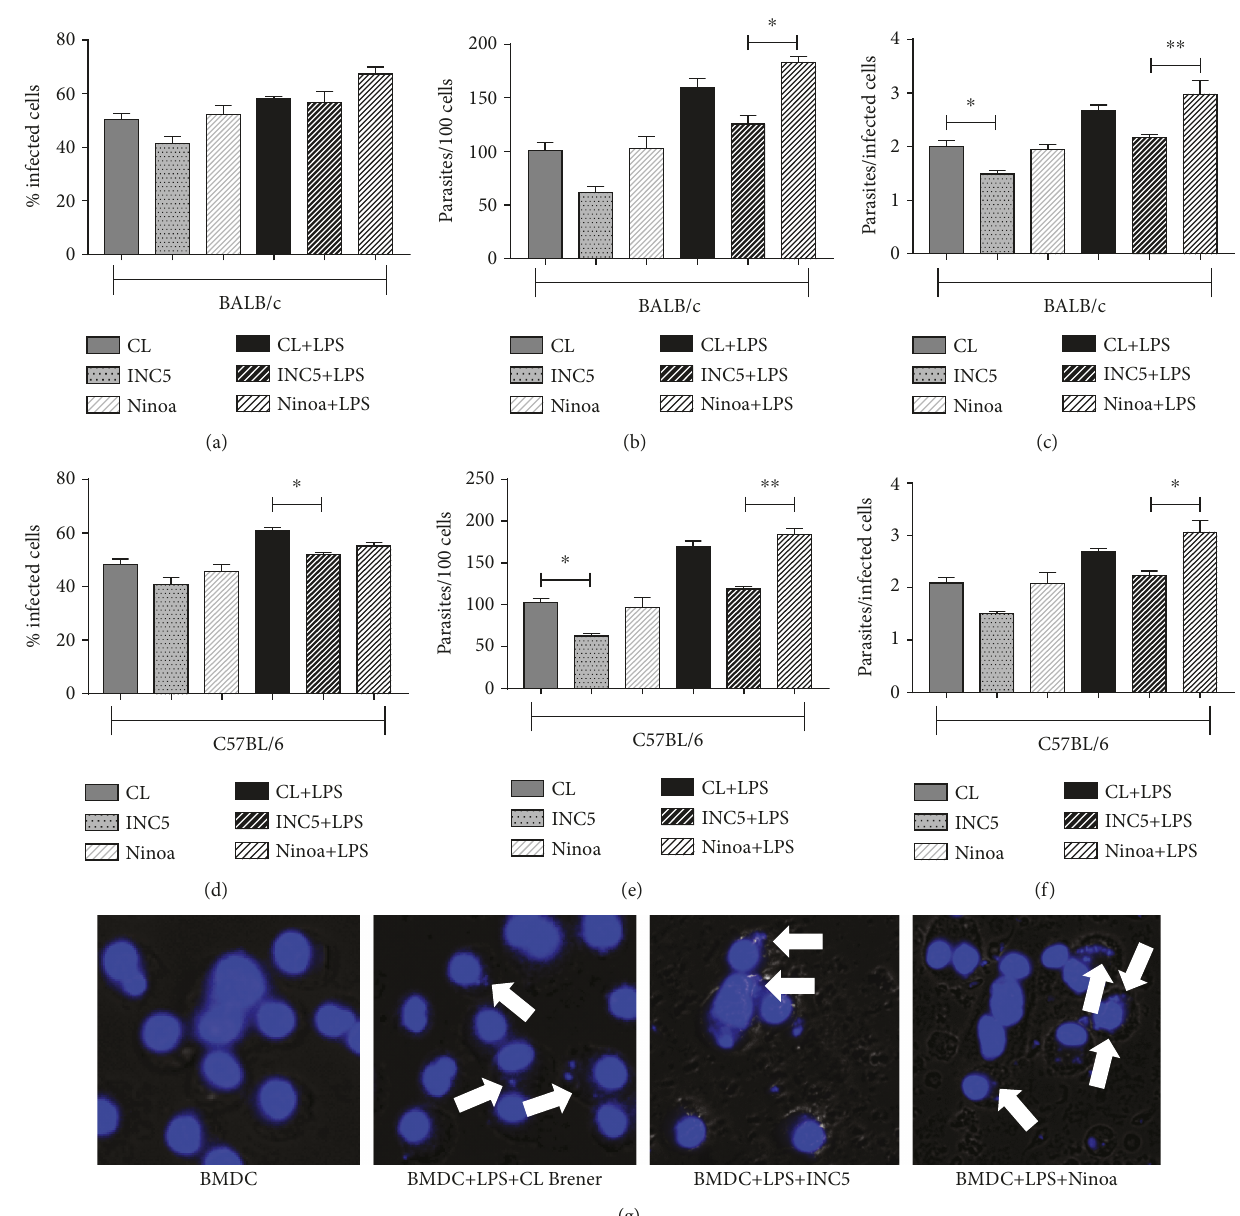
Figure 1: Trypanosoma cruzi infectivity in murine BMDCs from BALB/c and C57BL/6 mice. BMDCs with or without LPS stimulation (5 μ g/mL) were incubated for 18h with di ff erent T. cruzi strains (MOI 2:1) and stained with DAPI. (a) and (d) show the percentage of infected cells; in (b) and (e) the number of parasites per 100 cells and in (c) and (f) the ratio of parasites per infected cell are shown. (g) Representative images of BMDCs infected with T. cruzi after stimulation with LPS (5 μ g/mL) and stained with DAPI. Statistical analysis, when applicable, was performed with the Kruskal-Wallis test with Dunn ’ s posttest, where ∗ , ∗∗ p < 0 05